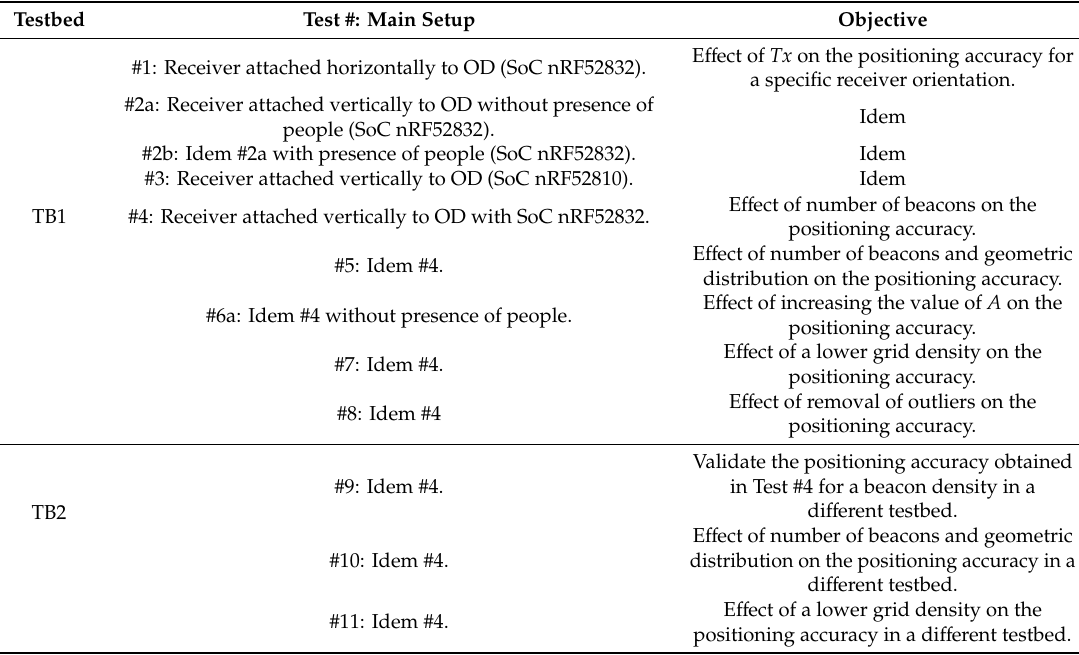
Table 4. Principal configuration of the tests carried out and their main objectives.